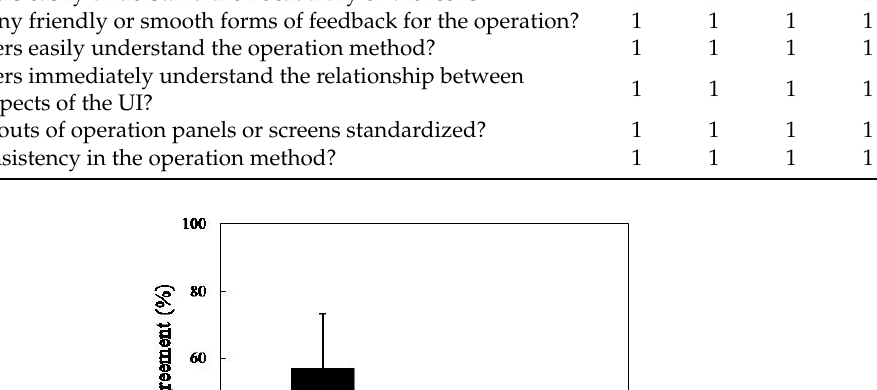
Table 8. Example of the evaluation of the proposed checklist (Pattern 1). “0” means “No”, “1” means “Yes”.)